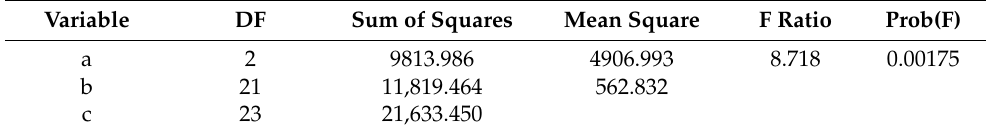
Table 4. The variance analysis.